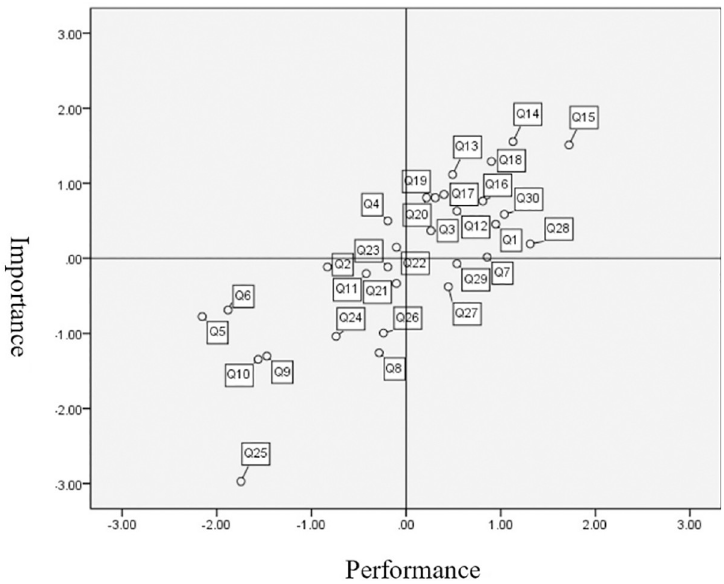
Fig 3. Results of importance-performance analysis for management aspects within the Guanwu National Forest Recreation Area in Taiwan. Q1 to Q30 can be matched with the questions in “Part III Operating Management Topics” in the questionnaire (see supporting